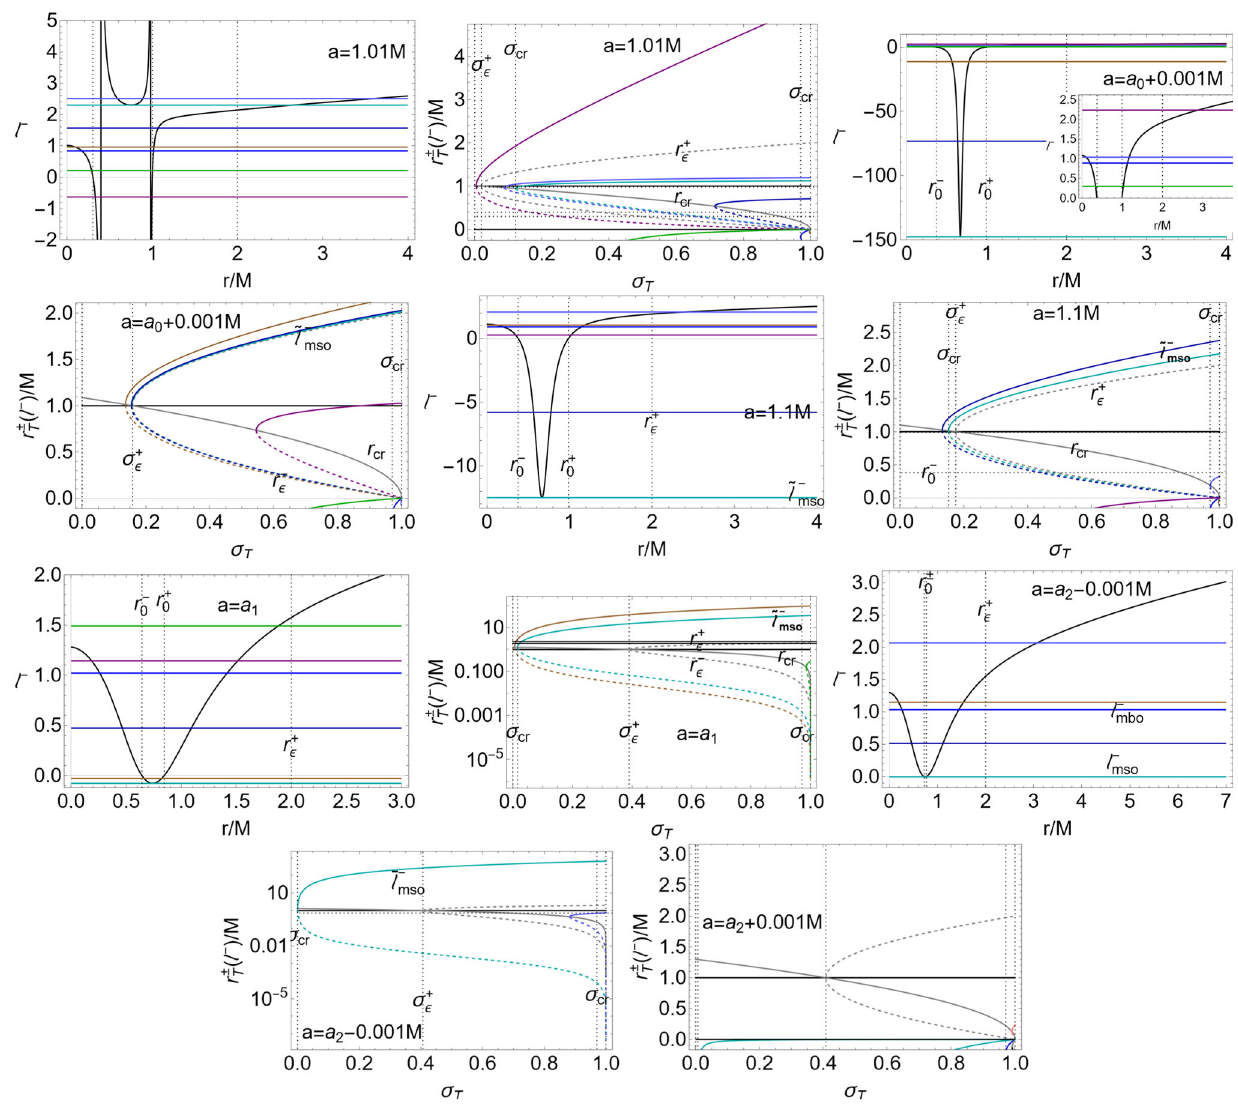
Fig. 4 Fluid specific angular momentum (cid:6) − for different spacetime plane, for different NS spin-mass ratio a / M signed on the panels. Plain spin a / M signed on the panels, darker-cyan curve is (cid:6) − mso , light-blue curves are r + (cid:2) while r − (cid:2) are dashed curves. For (cid:6) − > 0 inversion points curve is (cid:6) mbo . Marginally circular orbit radius is r − are only for space-like particles with ( E < 0 , L < 0 ) . Spins { a 0 , a 1 , a 2 } and marginally mbo stable orbits r − mso = {˜ r − mso , ¯ r − mso } . Horizontal lines select (cid:6) values used are defined in Table 2. Radius r ± (cid:11) are the outer and inner ergosurfaces. for the evaluation of the inversion radii. Inversion points r ± (cid:2) of Eq. (9) Plane curve σ + (cid:11) is defined in Eqs. (5) and radius r cr is in Eq. (10). Lim- iting plane σ cr is function σ σ a of Eq. (C7) on the selected fluid specific of the co-rotating and counter-rotating accretion with (cid:6) = (cid:6) − are shown angular momentum. There are no inversion points for co-rotating as functions of the planes σ ≡ sin 2 θ , where σ = 1 is the equatorial